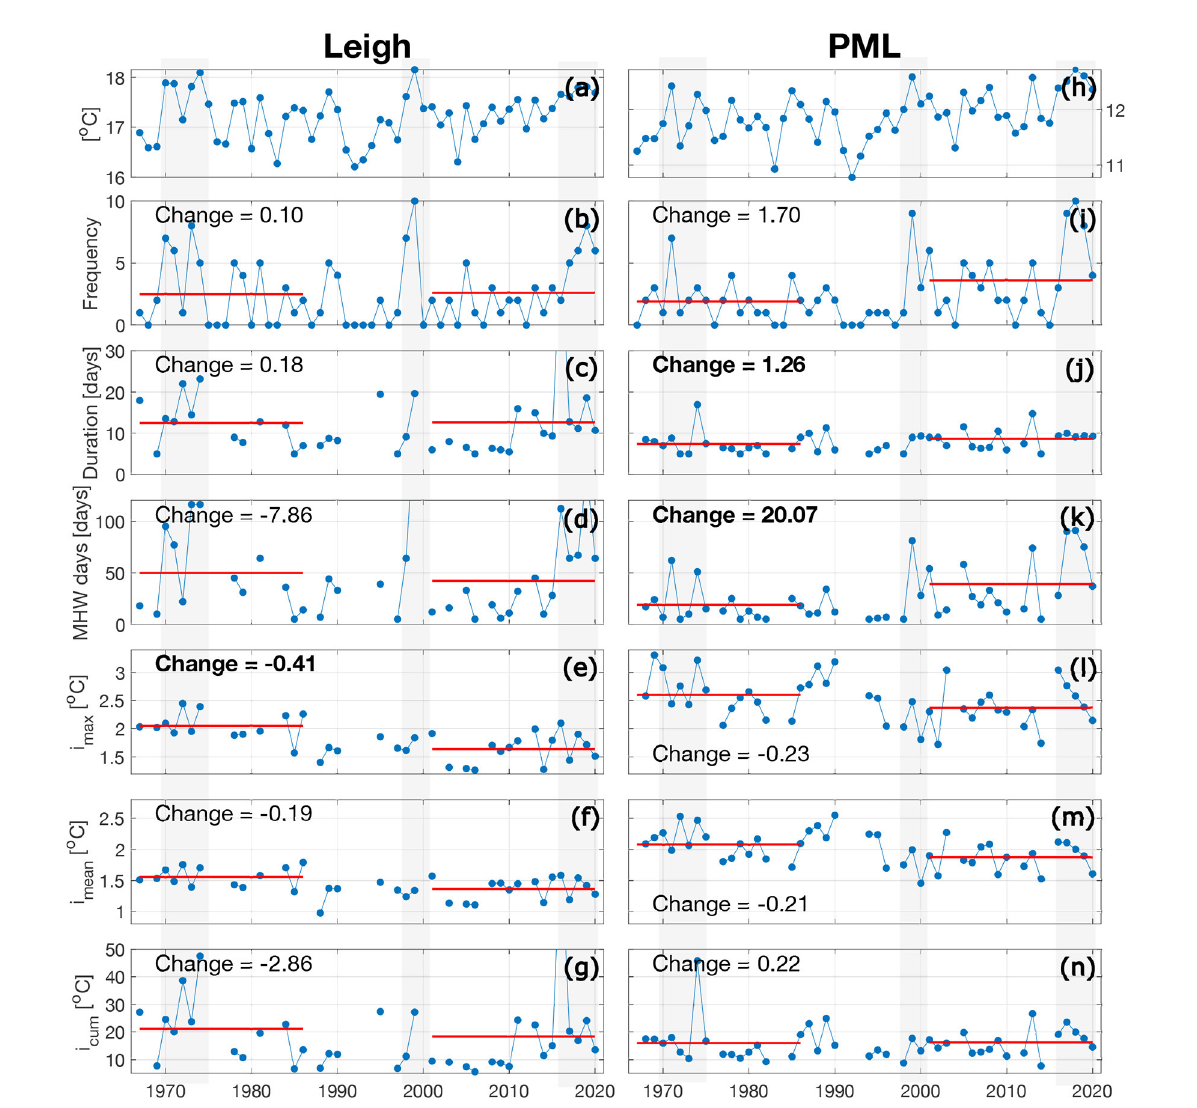
FIGURE5 Annual mean sea temperature at Leigh (a) and PML (h) along with annualized MHW metrics of event frequency, duration, number of MHW days, and intensities (maximum, mean, and cumulative) of MHW events at Leigh (b–g) and PML (i–n) . Red lines highlight the two time slices used for Kolmogorov-Smirnov tests and the mean value for each of the two periods. Periods of increased MHW frequency and days which coincide with “warm” years are highlighted with gray bars. Significant results are in